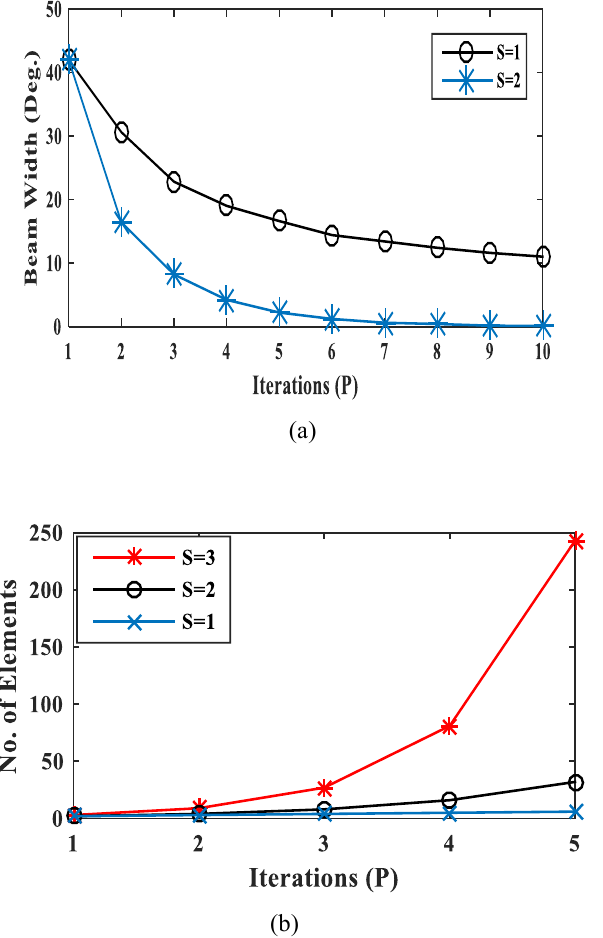
Figure.6. (a) Number of iterations with corresponding beam widths and (b) Number of iterations with number of elements.